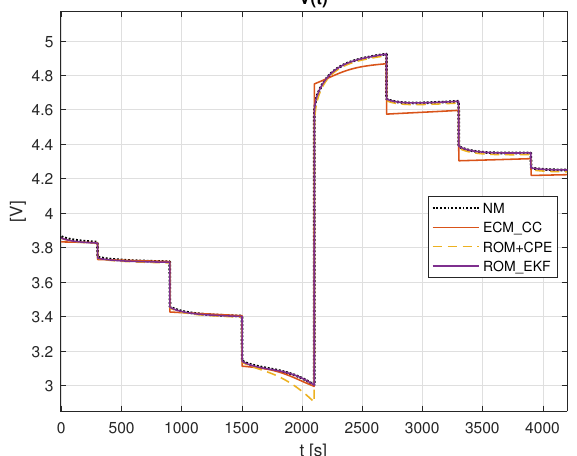
( t ) = [ 0.8,0.2 ] , SOC ∓ 0 NM